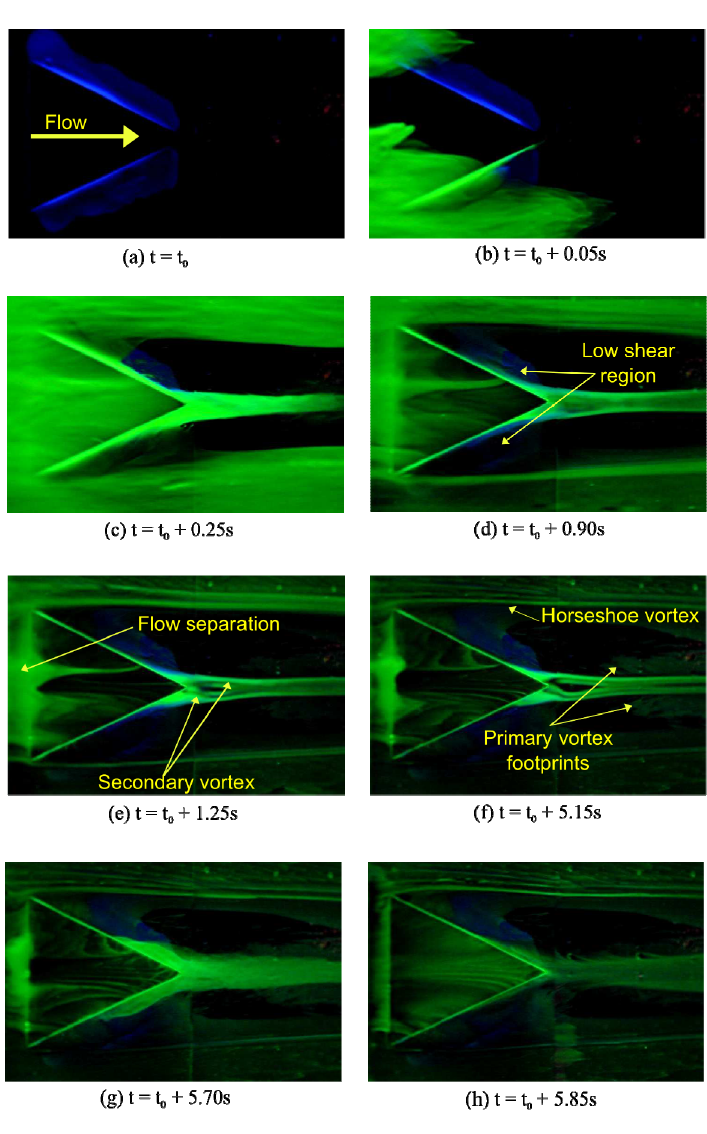
Figure 9. Chronology of surface oil-flow experiments from Saad et al. [22] (Reprinted with permission of the American Institute of Aeronautics and Astronautics).